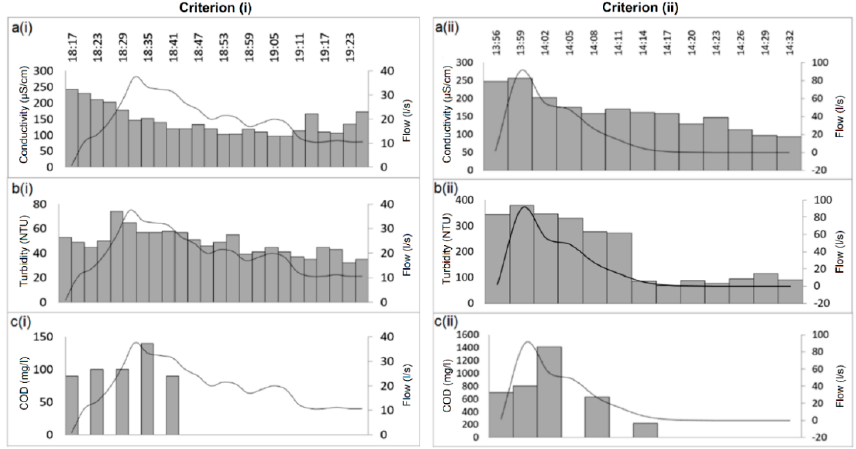
Figure A2. Variation of water quality parameters over time for the Multifamiliares CSO. Criterion ( i ) event with BOD 5 and COD values close to the mean. Criterion ( ii ) event with high BOD 5 and COD values. ( a ) conductivity, ( b ) turbidity and ( c ) COD.